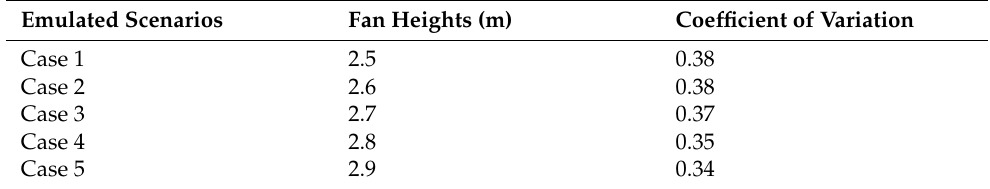
Table 4. Summary of the coefficients of variation of horizontal velocity profile for different fan heights.